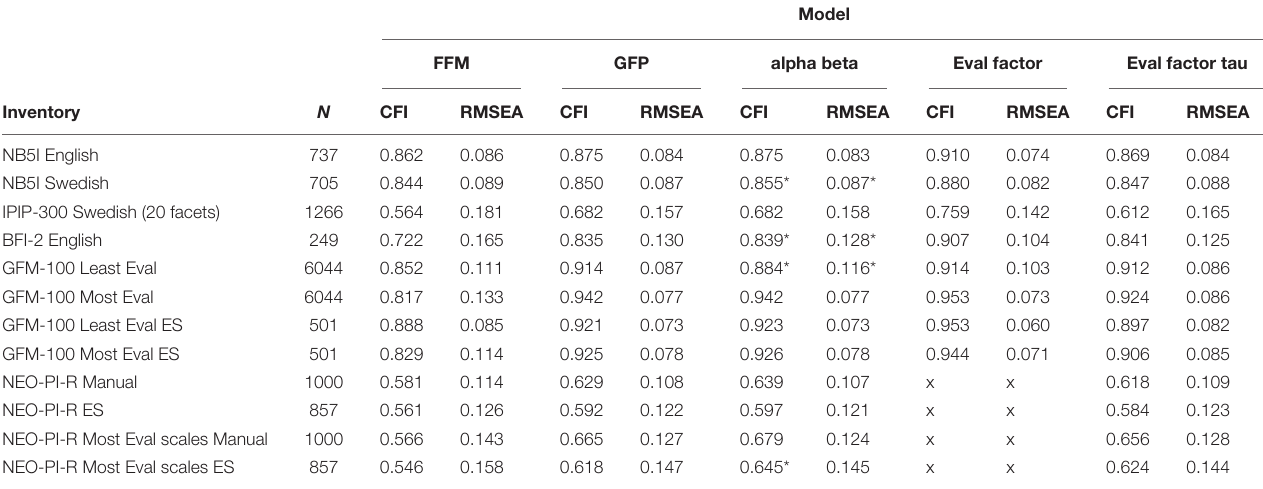
TABLE 2 | Fit indices of the FFM model, the GFP model, the alpha and beta model, the evaluative factor model and the tau equivalent evaluative model estimated from included inventories.